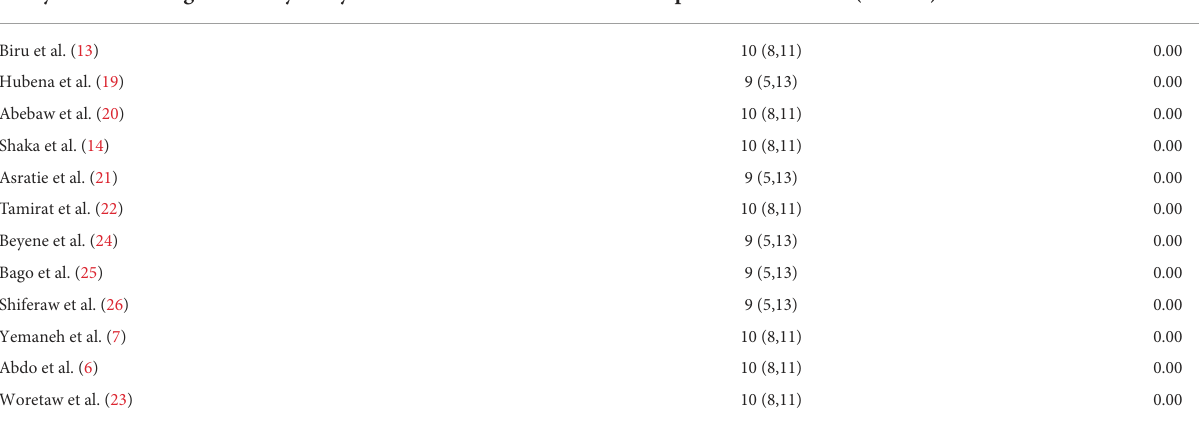
TABLE 3 Sensetivity analysis on studies included for the systematic review and meta-analysis on OVDs among mothers who gave birth in Ethiopia 2022. Study left out during sensitivity analysis